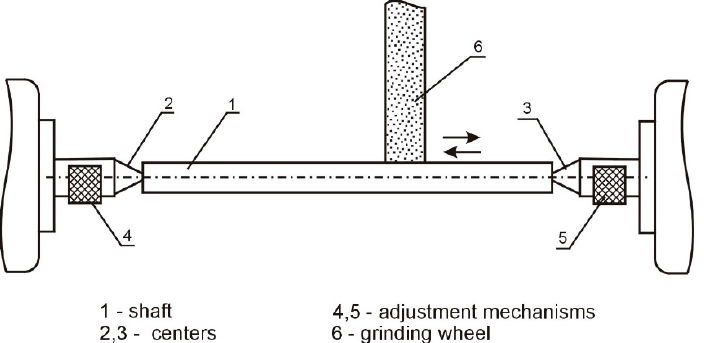
Figure 4. Schematic of the method of grinding low-stiffness shafts with an adjustment of compliance.